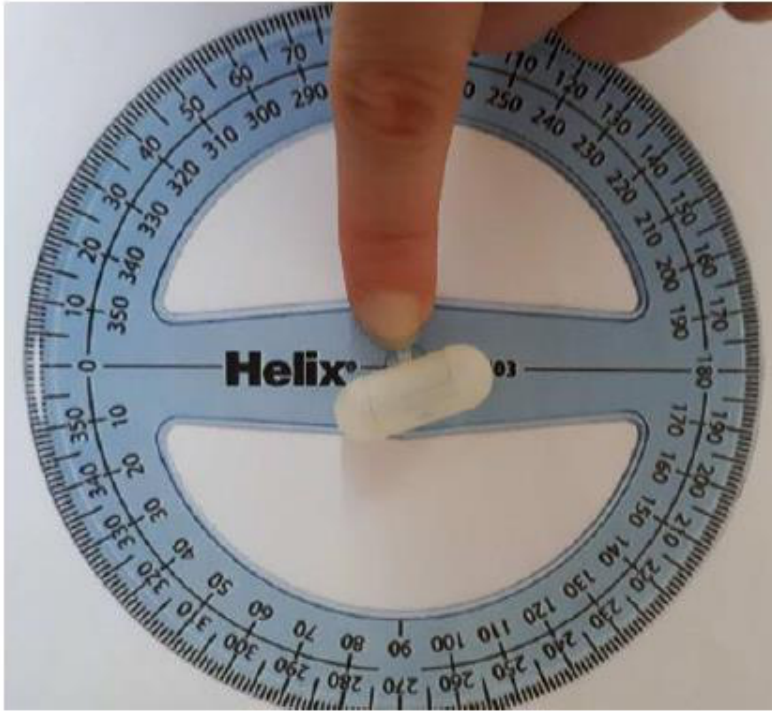
Figure 10. Left maximum inclination of configuration A.